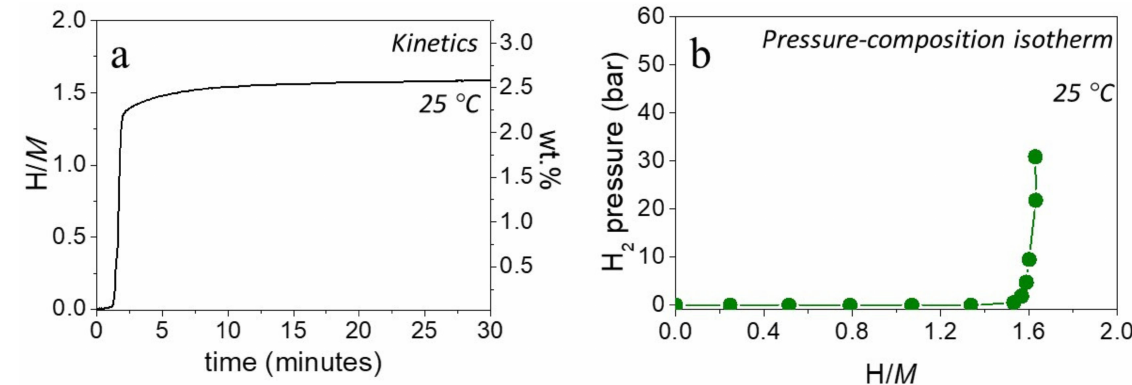
Figure 2. ( a ) Kinetics of absorption under 25 bar H 2 pressure at 25 ◦ C and ( b ) Pressure-composition isotherm at 25 ◦ C of Ti 0.30 V 0.25 Zr 0.10 Nb 0.25 Al 0.10 .